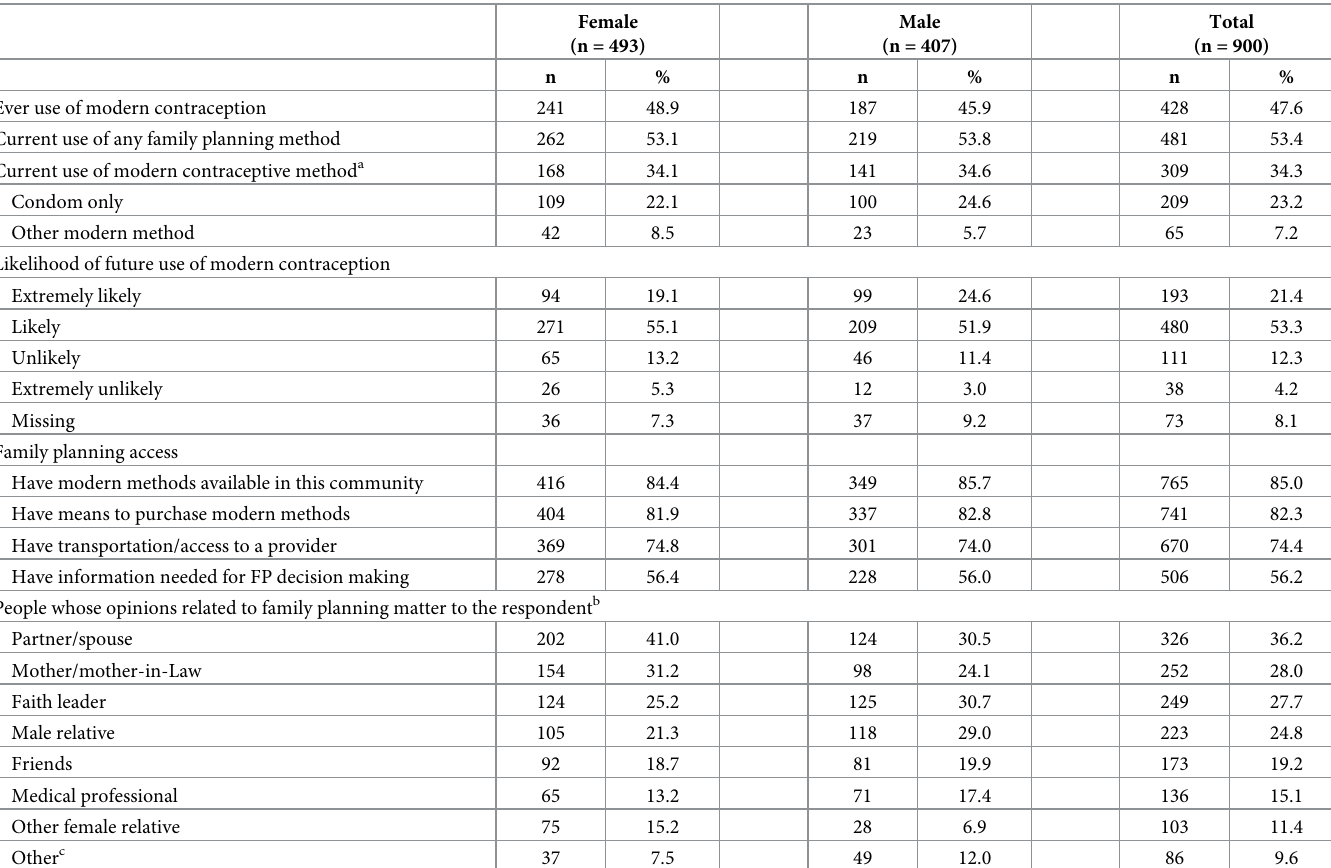
Table 2. Self-reported family planning use, intentions, self-efficacy, access, and reference groups among male and female survey respondents.